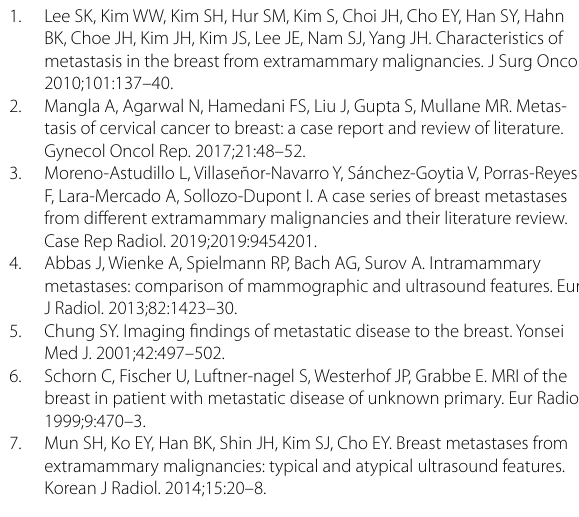
Fig. 7 Pathological findings of needle biopsy. Atypical cells with clear cytoplasm were observed ( a , hematoxylin and eosin staining, of cell–cell adhesion is one of the key findings that indicate non-epithelial neoplasm. Tumor cells were positive for HMB45 ( b ). A horizontal bar indicates 100